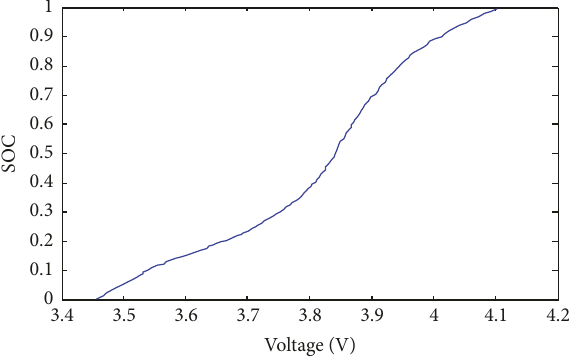
Figure 7: Relation of SOC and open-circuit